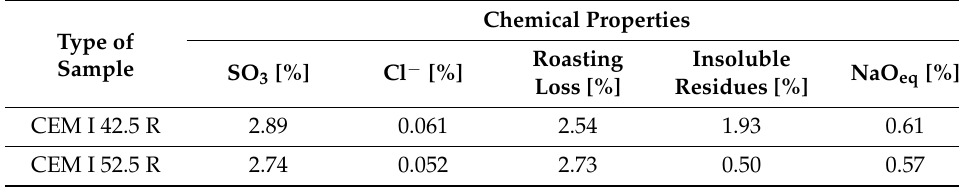
Table 1. Chemical properties of cement.